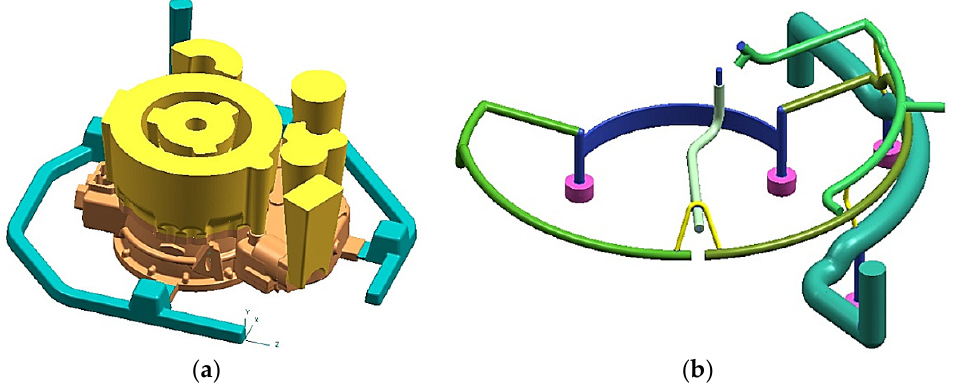
Figure 1. ( a ) 3D casting model with gating system; ( b ) 3D chromium-nickel tube collector model.